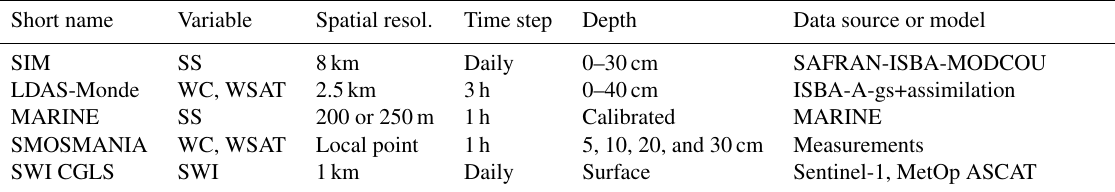
Table 2. Summary of the five products compared in this work for soil moisture estimation. Shown are the SSD (SS), soil water content (WC), soil water content at saturation (WSAT) or Soil Wetness Index (SWI), the spatial and temporal resolution of the product, and the data source or the model used to obtain the